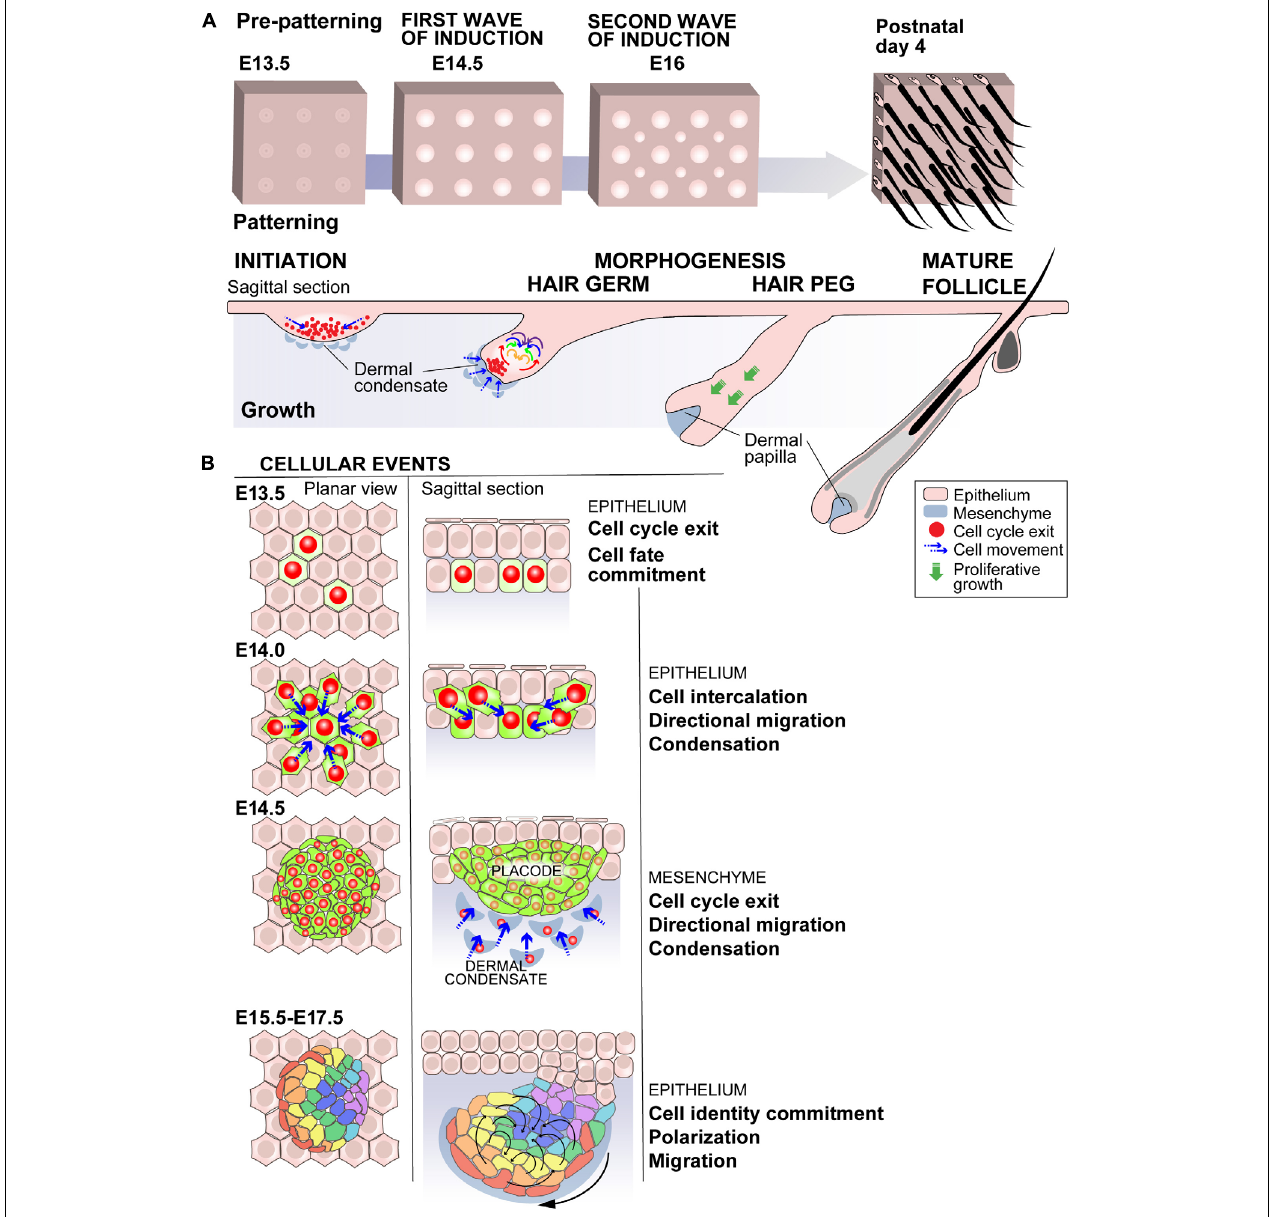
FIGURE 1 | Mammalian early embryonic hair development, a model for cellular mechanisms driving ectodermal organogenesis. (A) Mice have four different hair types that arise in three successive waves of hair follicle induction. The first wave of embryonic development of hair follicles in the mouse back skin starts with the establishment of a pre-pattern around embryonic day 13.5 (E13.5) creating the spacing of the hair follicles by a reaction-diffusion type signaling system. At E14.5 the initial thickening of the epidermis, the epithelial placode, is induced by a signal from the mesenchymal compartment the dermis. The epithelium of the hair germ polarizes, and at the same time mesenchymal cells start forming a dermal condensate. The epithelium then buds by cell proliferation invaginating into the dermis to form the hair peg and the condensed mesenchyme engulfed by the epithelium becomes the dermal papilla. This is followed by further differentiation in a mature hair follicle. The second wave of hair morphogenesis takes place around E16–E17 and third at E18- postnatal day 1 (P1) with specific molecular patterning mechanisms for each. The mature hair follicle cycles producing new hairs throughout the adult life. (B) The hair has been one of first ectodermal model organs in which live imaging approaches have brought understanding of the cellular dynamics of the morphogenesis and patterning especially in the early stages of morphogenesis: during the first wave of hair follicle induction the cellular events start with a cell fate commitment and cell cycle exit in the prospective placode cells at E13.5. These cells then intercalate and migrate centripetally to condense into a placode thickening at E14.5. The placode signals to the mesenchymal compartment and the dermal cells commit to dermal condensate fate, exit the cell cycle and migrate to form the dermal condensate. The epithelial compartment concomitantly polarizes. The cellular mechanisms of hair follicle polarization have been studied during the second wave of hair follicle induction (E15.5–E17.5). The polarization takes place through planar cell polarity mediated mechanisms and the cells acquire specific fates and collectively actively redistribute into a polarized structure (Duverger and Morasso, 2009; Ahtiainen et al., 2014; Biggs and Mikkola, 2014; Biggs et al., 2018; Cetera et al., 2018).